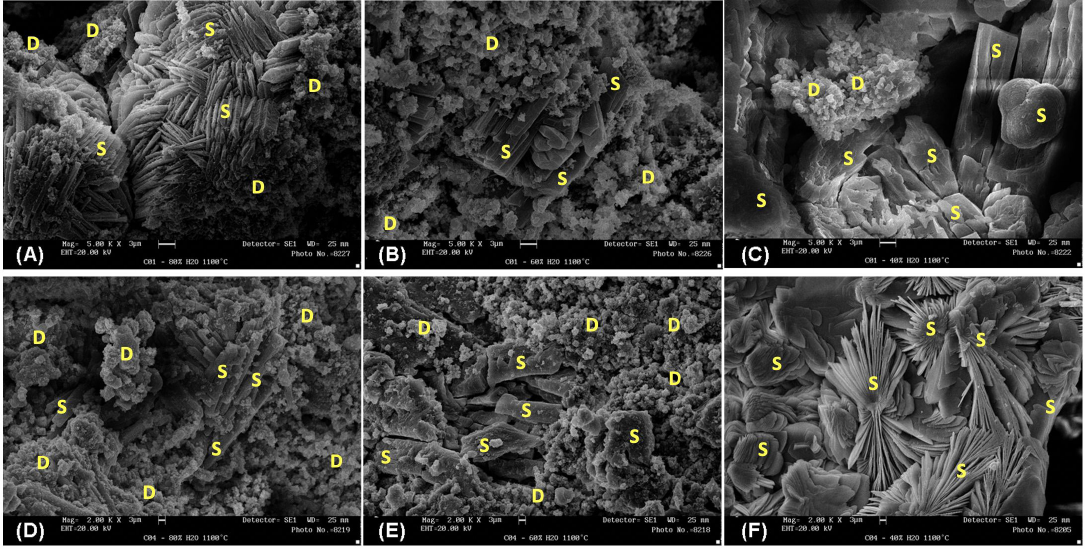
O; (B) C_01 – 60% H 2